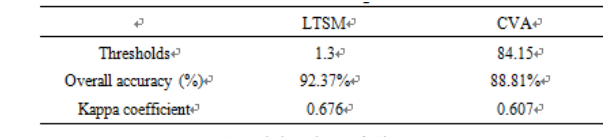
Table 2 Accuracies of three change detection